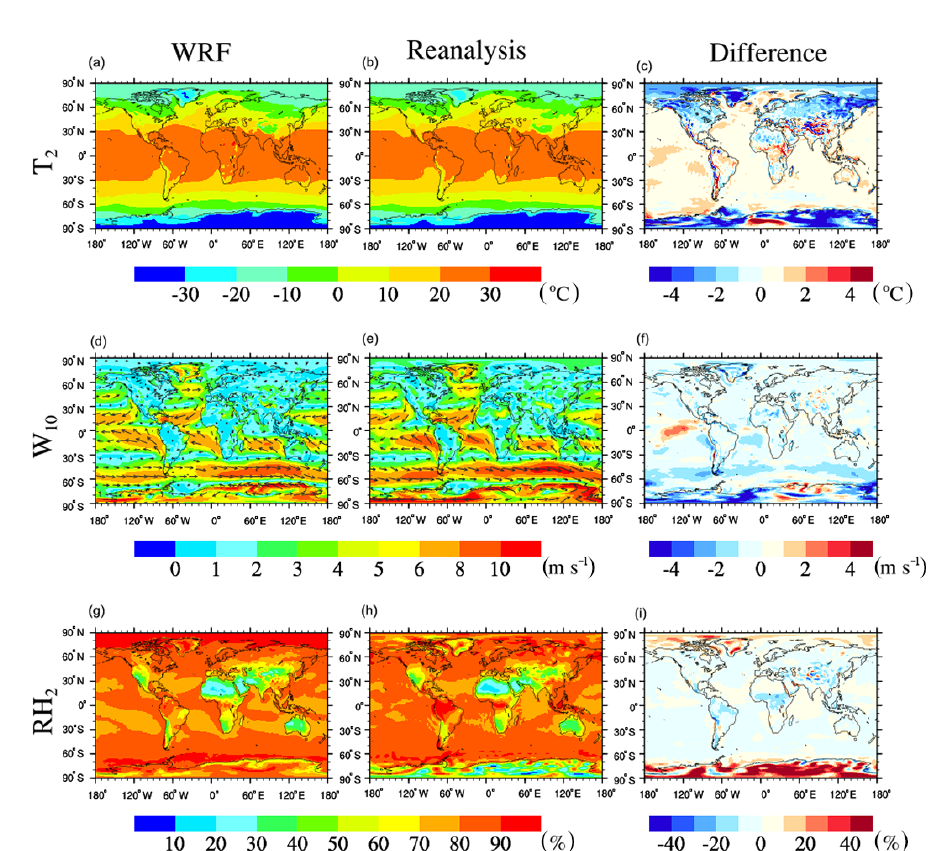
Figure 2. Comparison of annual meteorological fields. The left column (a, d, g) is the WRF simulation, the middle column (b, e, h) shows reanalysis data, and the right column (c, f, i) shows the difference between the simulation and reanalysis (WRF–reanalysis). The reanalysis data are NCEP Reanalysis